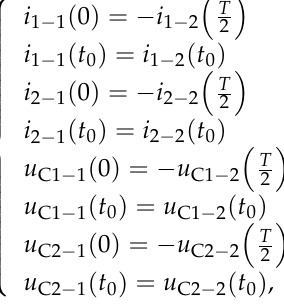
the differential equations can be